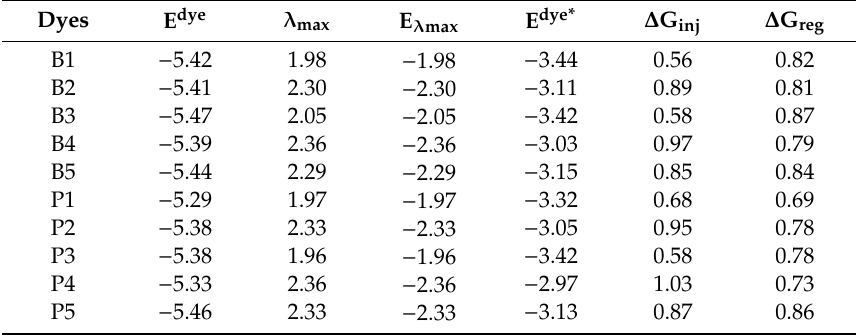
Table 5. Parameters of interfacial electron injection and dye